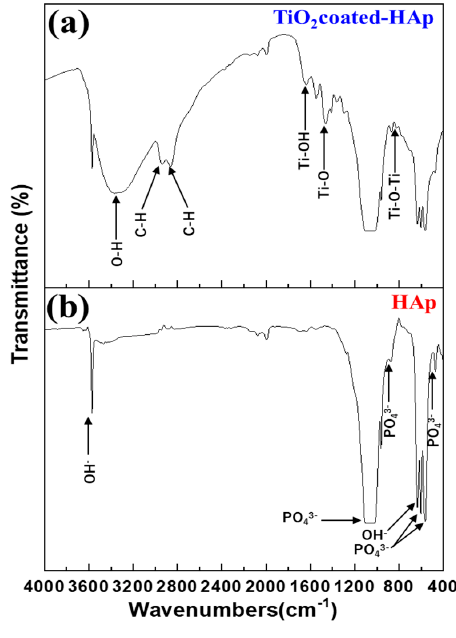
Figure 3. FT-IR spectra of ( a ) the TiO 2 -coated HAp and ( b ) hydrothermally-synthesized HAp.